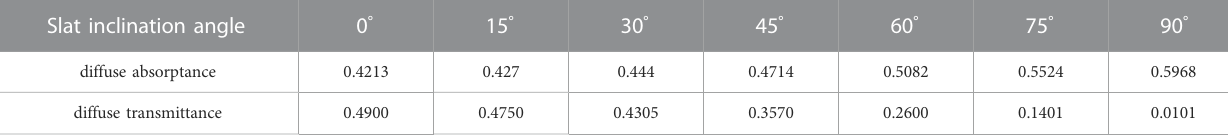
TABLE 2 Summary of diffuse absorptance and diffuse transmittance, for different slat inclination angles.